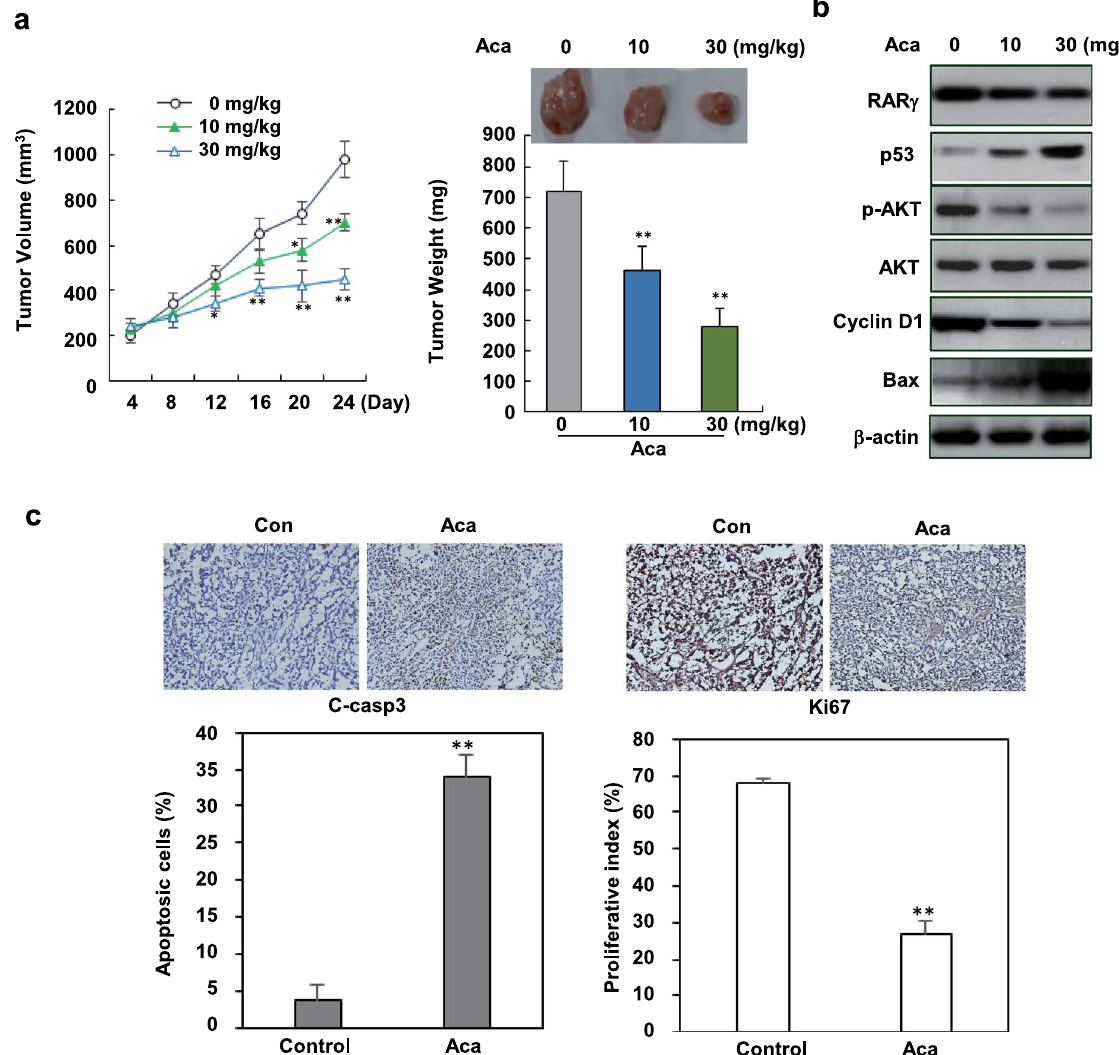
Figure 6. In vivo anti-tumor activity of acacetin. ( a ) Mice were subcutaneously transplanted with HepG2/RAR γ liver cancer cells. After 1 week, mice with palpable tumors were treated with 10 mg/kg (n = 6) and 30 mg/kg acacetin (n = 6) or vehicle (n = 6) by i.p. once every other day. Tumor volume was examined every 4 days after treatment. 3 weeks later of post-treatment, the mice were sacrificed and the tumors were collected for further assays. Representative tumors were shown and the effects of acacetin on tumor weights were evaluated. ( b ) The tumors were lysed and immunoblotted for assaying the expression of RAR γ , p53, Bax, Cyclin D1, and the total and phosphorylated AKT proteins. ( c ) The effects of acacetin on the expression of cleaved caspase 3 (indicator of apoptosis) and Ki67 (proliferative index) were conducted by immunostaining. All the slides were co-stained with hematoxylin. The apoptotic and proliferative cell numbers were quantitated. All blots were cropped to remove irrelevant or empty